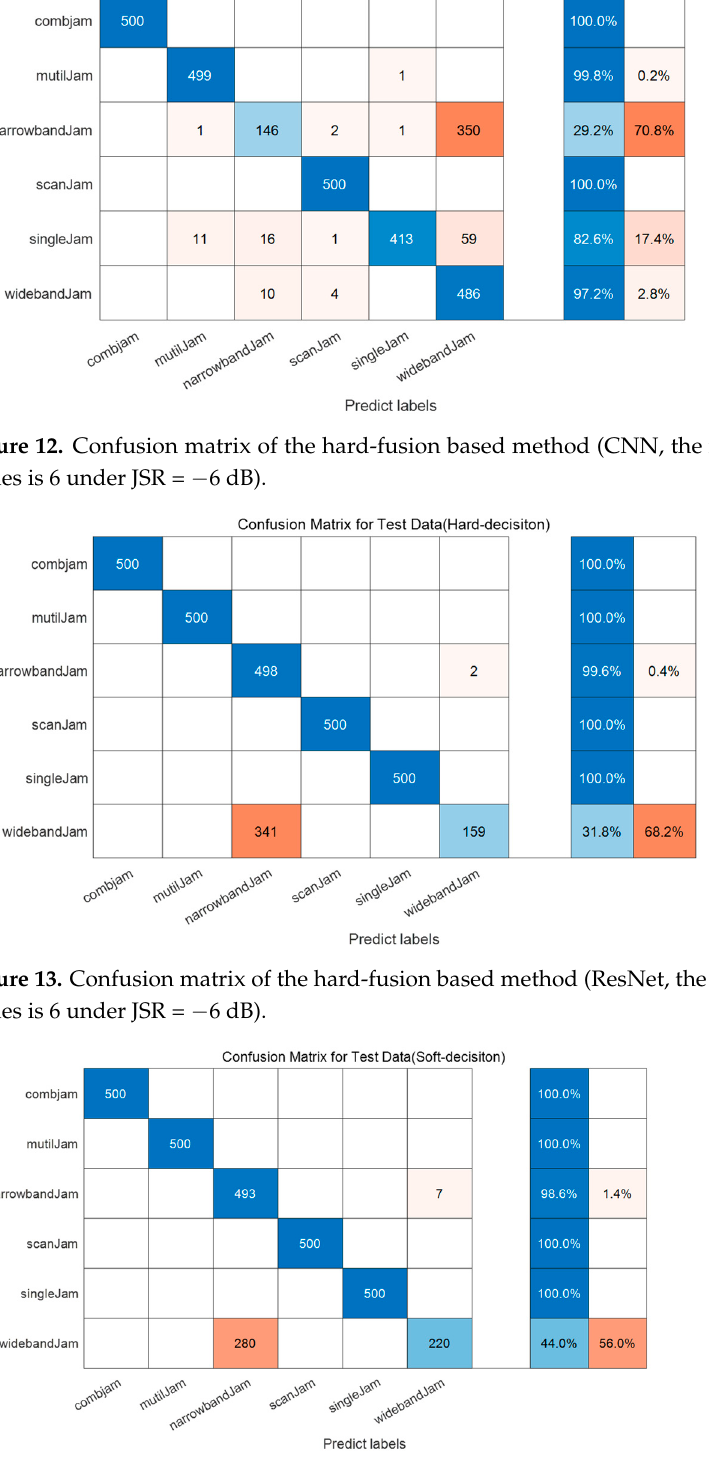
Figure 14. Confusion matrix of the soft-fusion based method (ResNet, the number of co-cognitive nodes is 6 under JSR = − 6 dB).